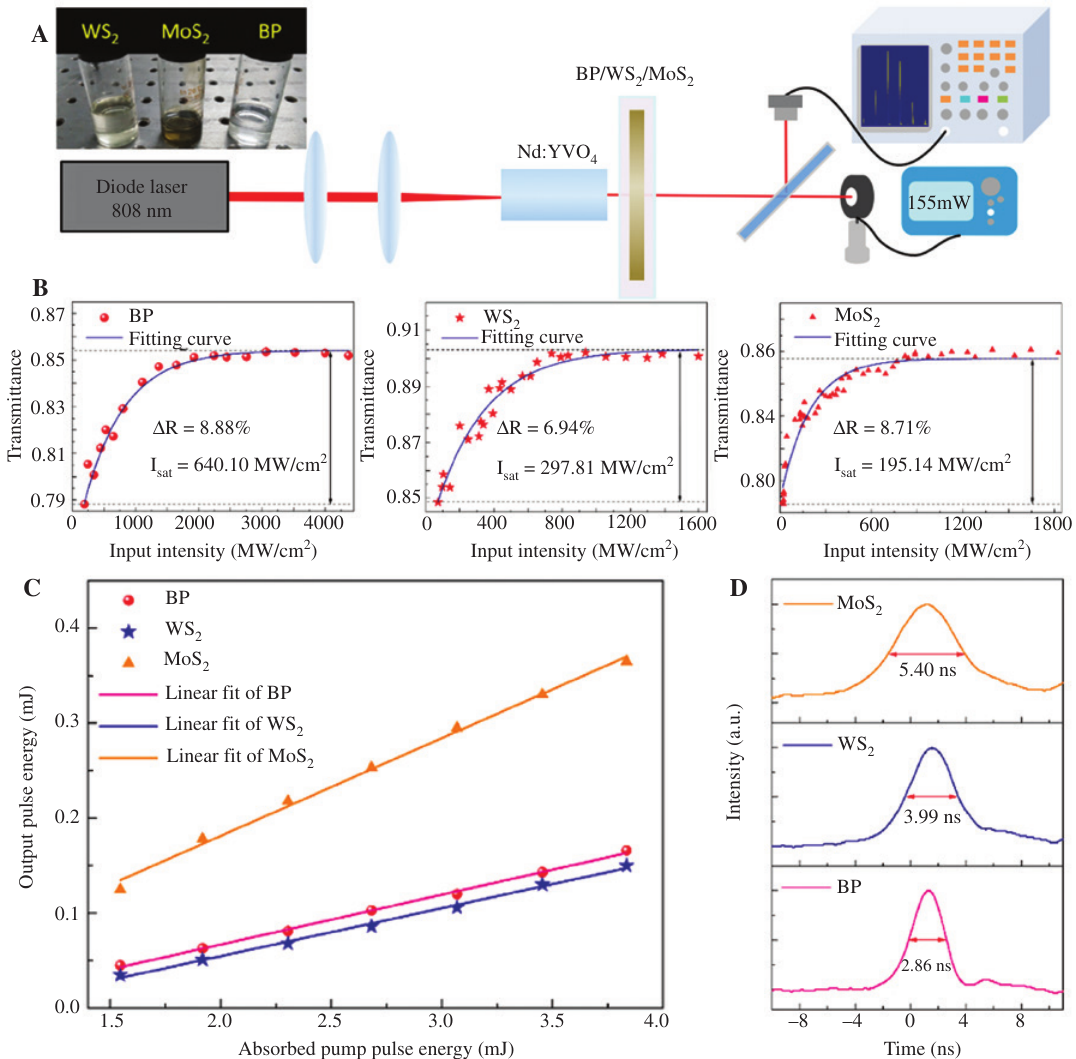
and MoS Q-switched near-infrared lasers. Figure 15: Performance of BP, WS 2 2 (A) Schematic of WS , MoS , and BP SAs Q-switched lasers. Inset shows their dispersion solutions. (B) Saturable absorption properties of 2 2 BP, WS , and MoS solutions. (C) The output pulse energy vs. absorbed pump pulse energy. (D) Pulse durations corresponding to BP, WS 2 2 and MoS , respectively. Reproduced with permission [224]. Copyright 2017, Optical Society of 2